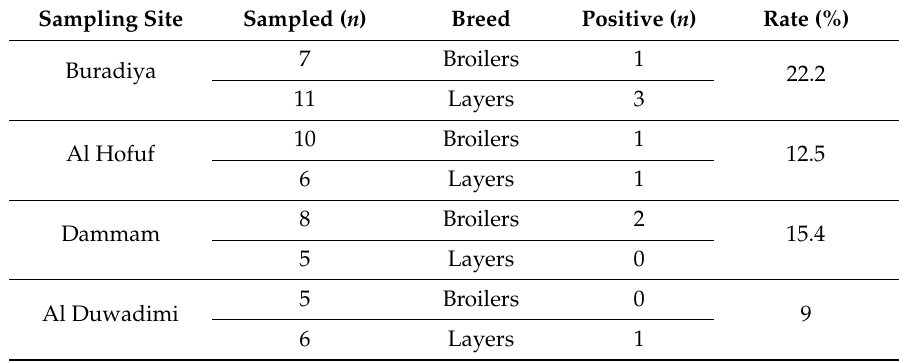
Table 1. Sampling data and prevalence of infectious bronchitis viruses (IBVs) in four geographical regions in Saudi